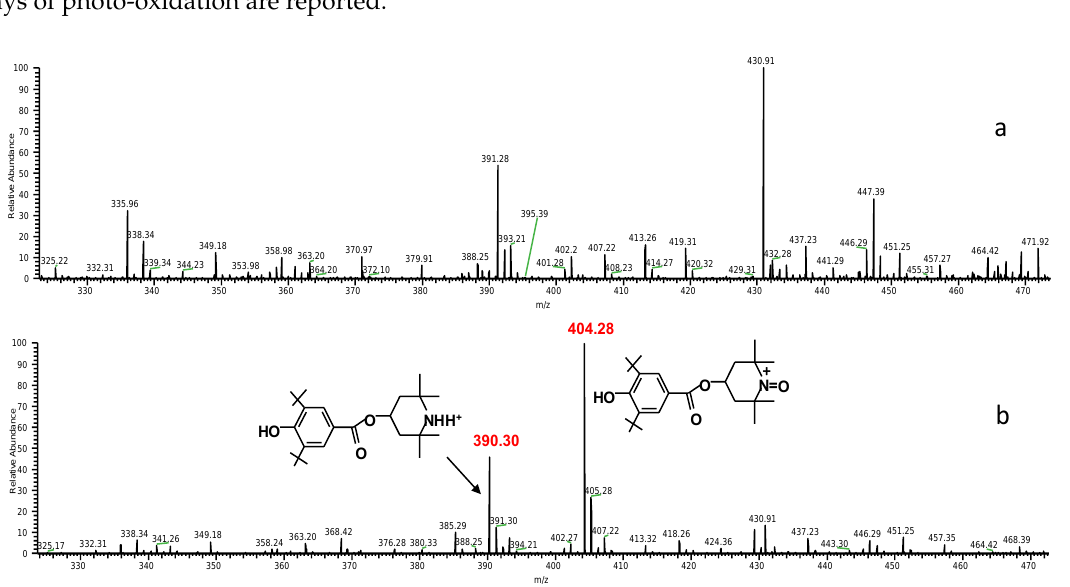
Figure 2. Electrospray ionization-mass spectroscopy (ESI-MS) registered in positive mode, in the mass range 300–480 m / z , of the products extracted from EOC- g -(BHB-T)_2 virgin sample ( a ) and photo-oxidized for 6 days ( b ).